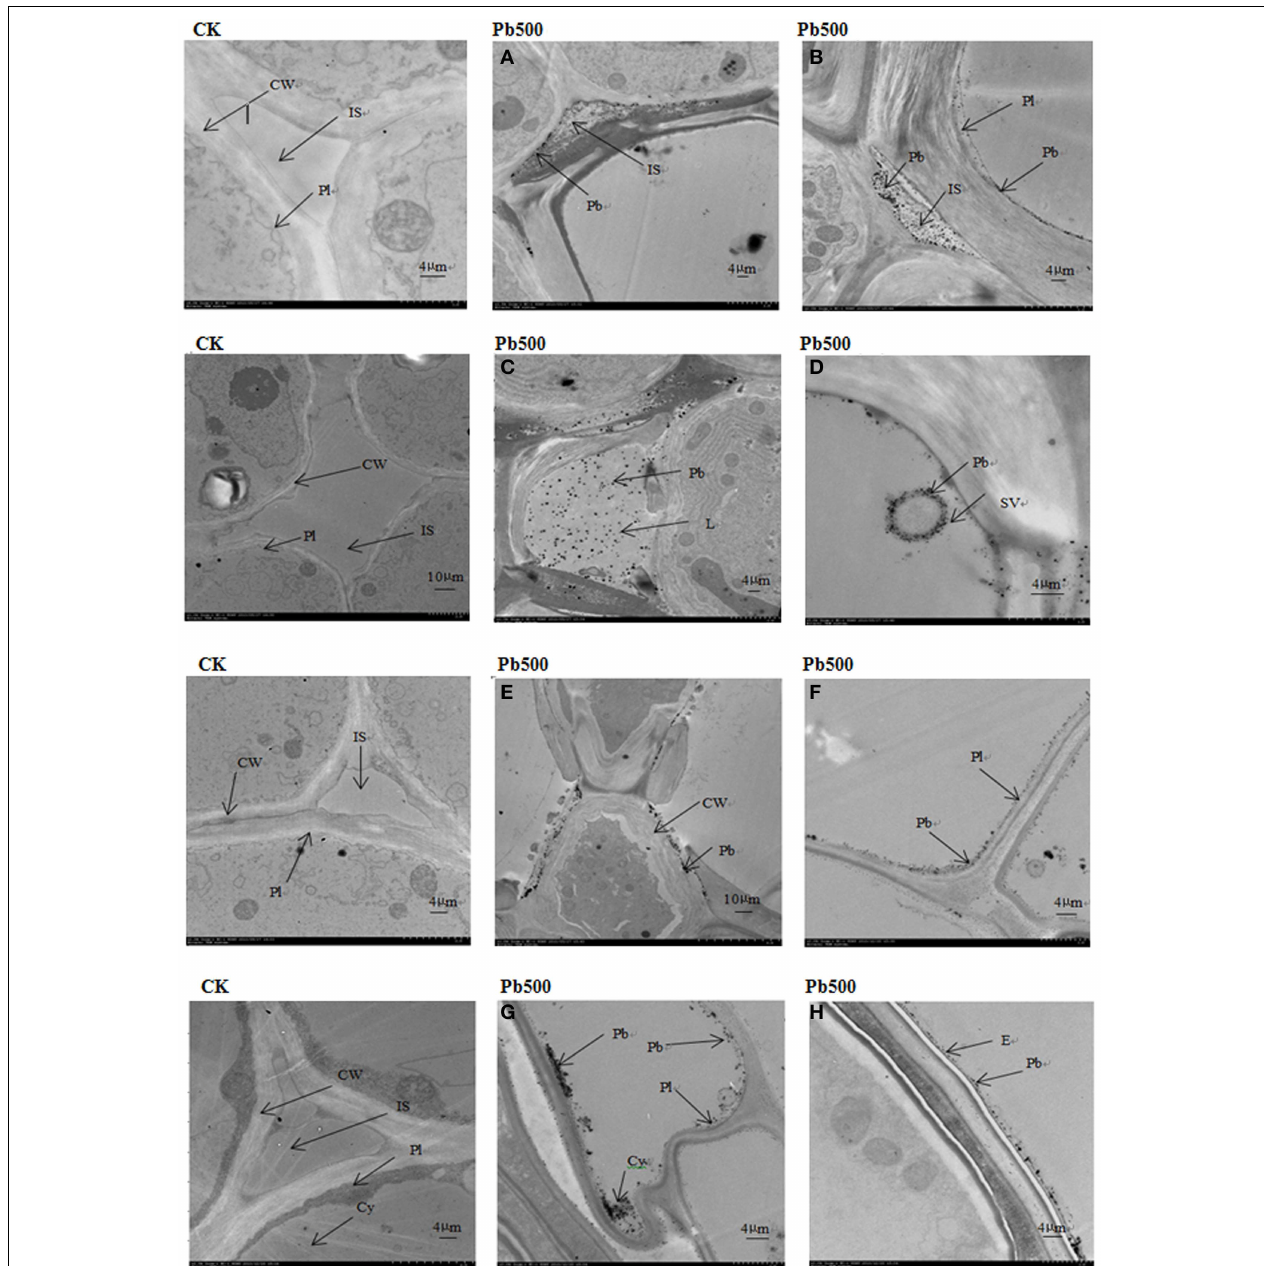
FIGURE 6 | Ultrastructure of transverse sections of roots in NAU-XLM under 500mg/L Pb treatment. Electron-dense particles were localized in IS, intercellular space (A,B) ; L, lumen (C) ; SV, small vacuole (D) ; CW, cell wall (E) ; Pl, plasmalemma (F) ; Cy, cytoplasm (G) ; and E, epidermis (H) .